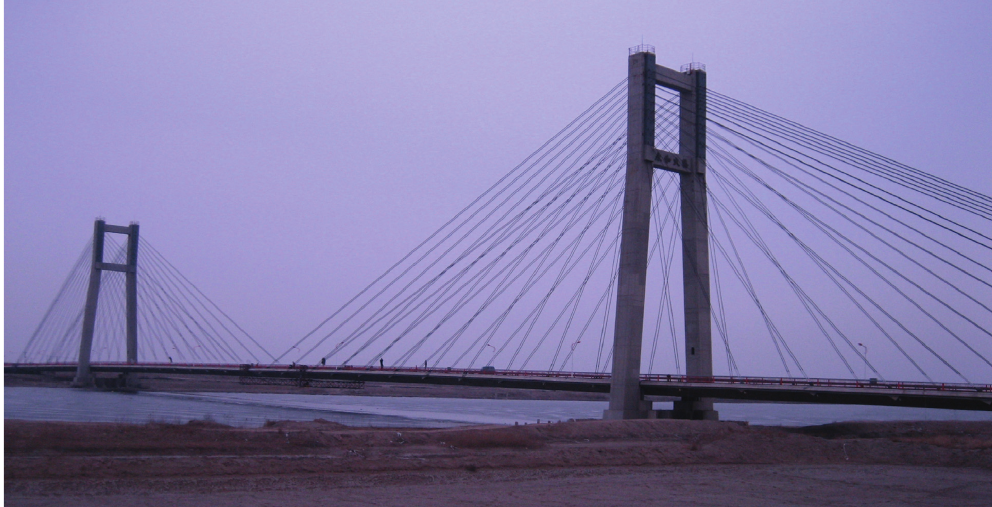
Figure 1: A field photograph of Yonghe